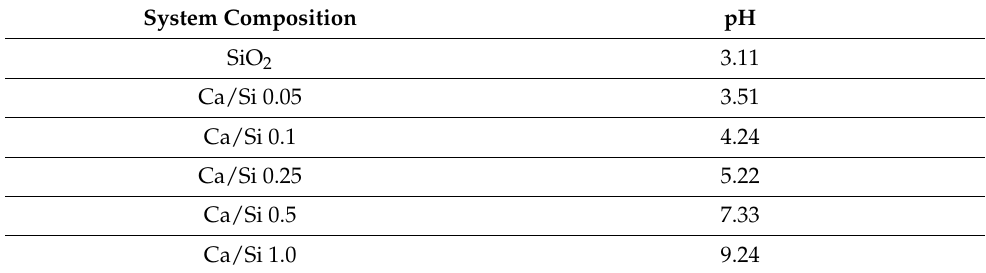
Table 2. Values of pH of the gels after